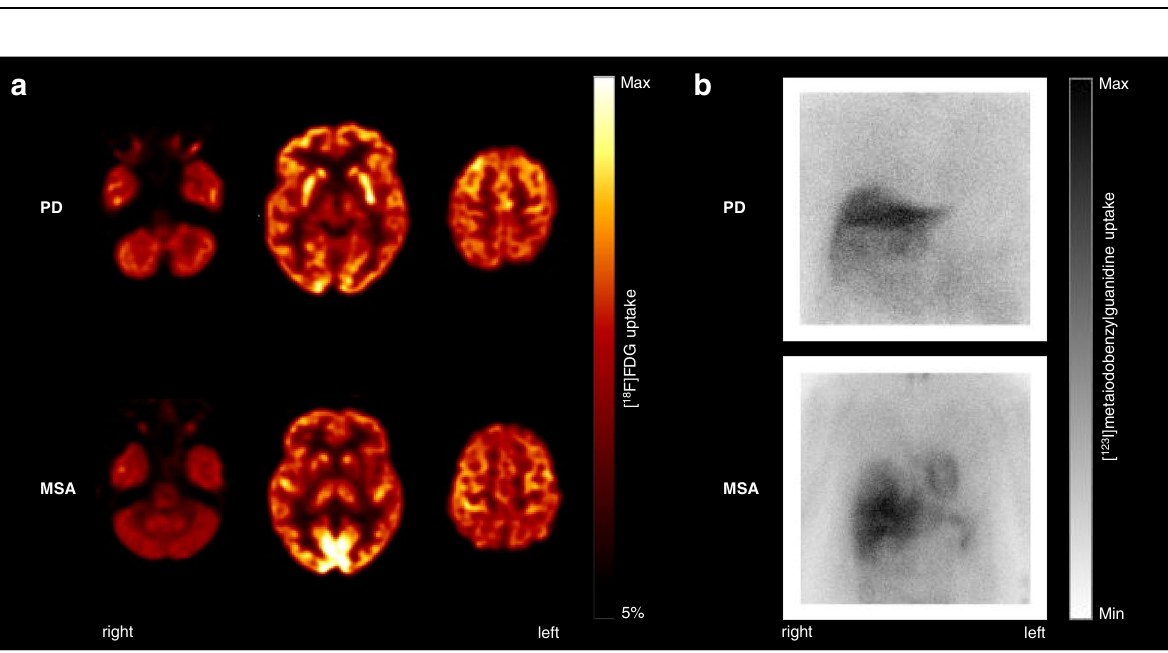
Fig. 3 Typical FDG PET and MIBG scintigraphy fi ndings in individual patients with Parkinson ’ s disease and multiple system atrophy. a Spatially normalized transaxial FDG PET slices at the level of cerebellum, basal ganglia, and dorsal frontoparietal cortex. Datasets were thresholded for optimal display. b Anterior view of planar MIBG scintigraphy. The patient with PD shows a typical relative hypermetabolism of the bilateral putamen and no cardiac MIBG uptake. The MSA patient is characterized by hypometabolism of the putamen (particularly on the left side), the bilateral cerebellum, and a preserved cardiac uptake on MIBG scintigraphy. PD Parkinson ’ s disease, MSA multiple system